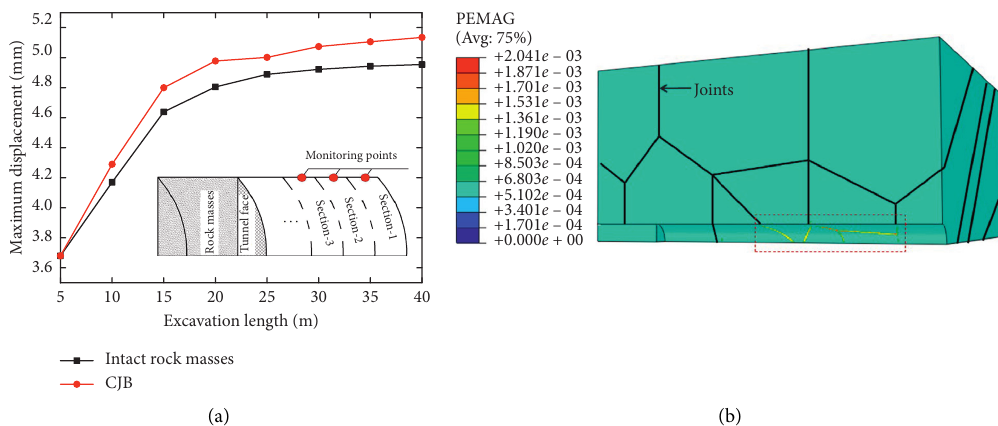
Figure 15: Numerical simulation results of tunneling in CJB: (a) curves of maximum displacement in each excavation step in CJB and intact rock masses; (b) the contour of plastic strain magnitude (PEMAG) tunneling in